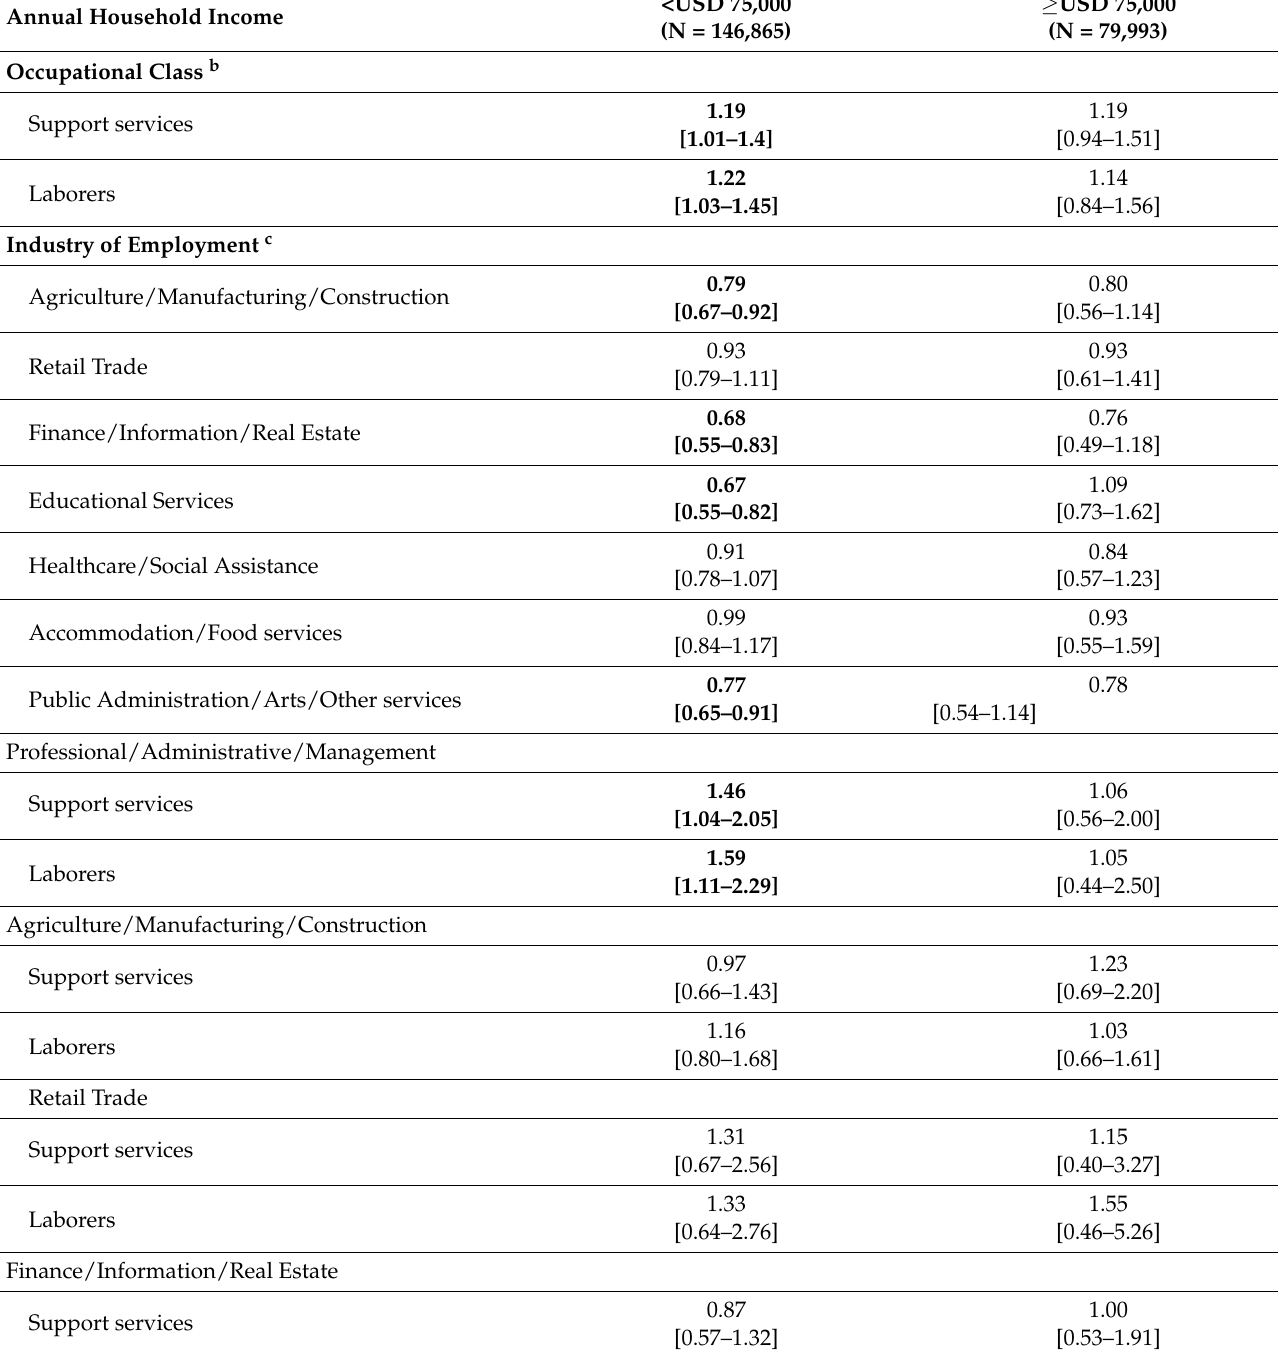
Table 5. Adjusted Prevalence Ratios (95% Confidence Intervals) for the Association Between Oc- cupational Class (compared to Professional/Management positions) and Industry of Employment (compared to the Professional/Administrative/Management Industry) and Serious Psychological Distress, Stratified by Annual Household Income, National Health Interview Survey, 2004–2018, (N = 226,858) a